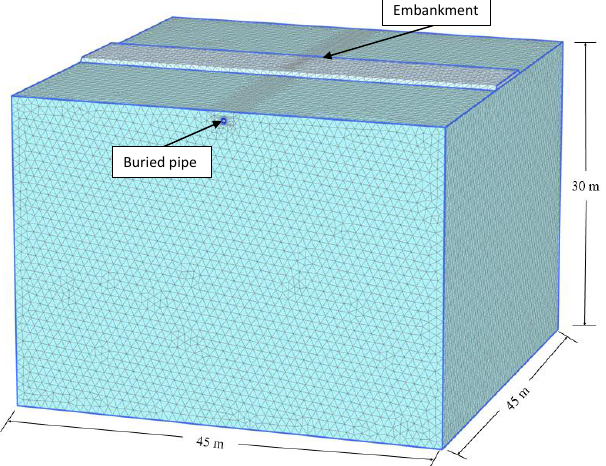
Figure 3. The mesh of the finite element model of the study.